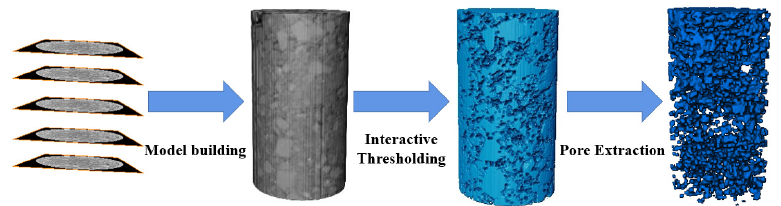
Figure 5. The construction process of the three-dimensional pore structure model.